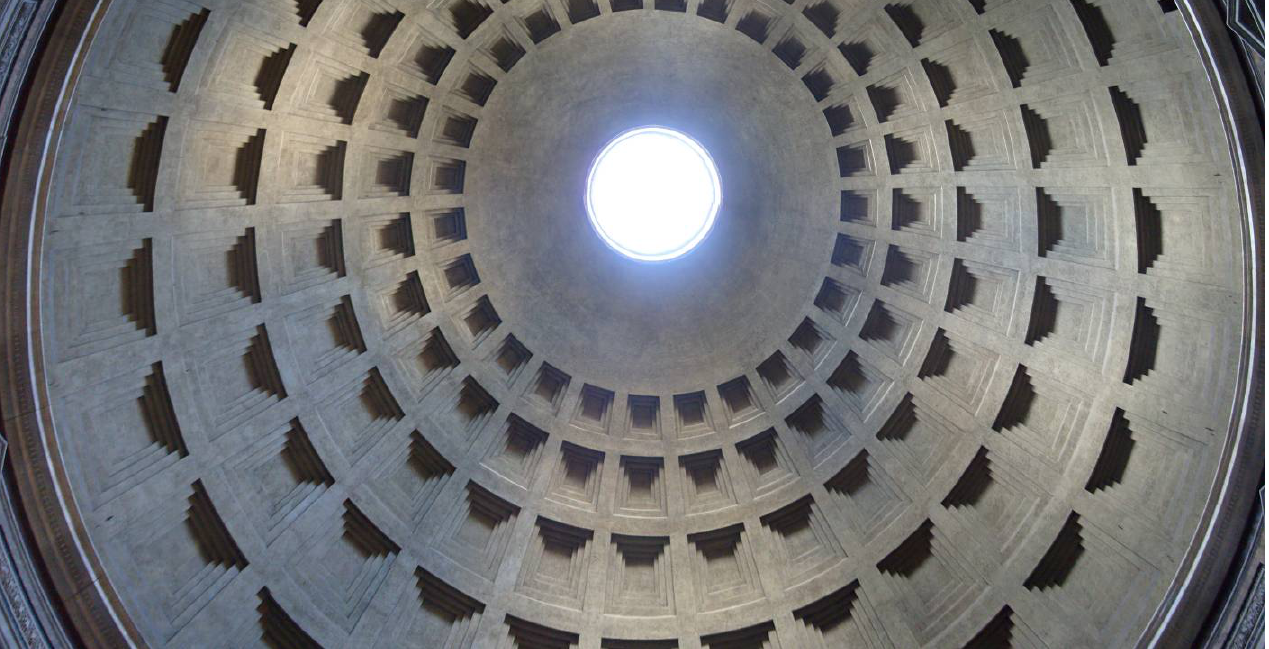
Figure 9. The thick walls and lack of side windows in the Pantheon help create a working sanctuary by cutting off external stimuli. Likewise, the dome possesses hermetic womb-like qualities. Photograph by author.